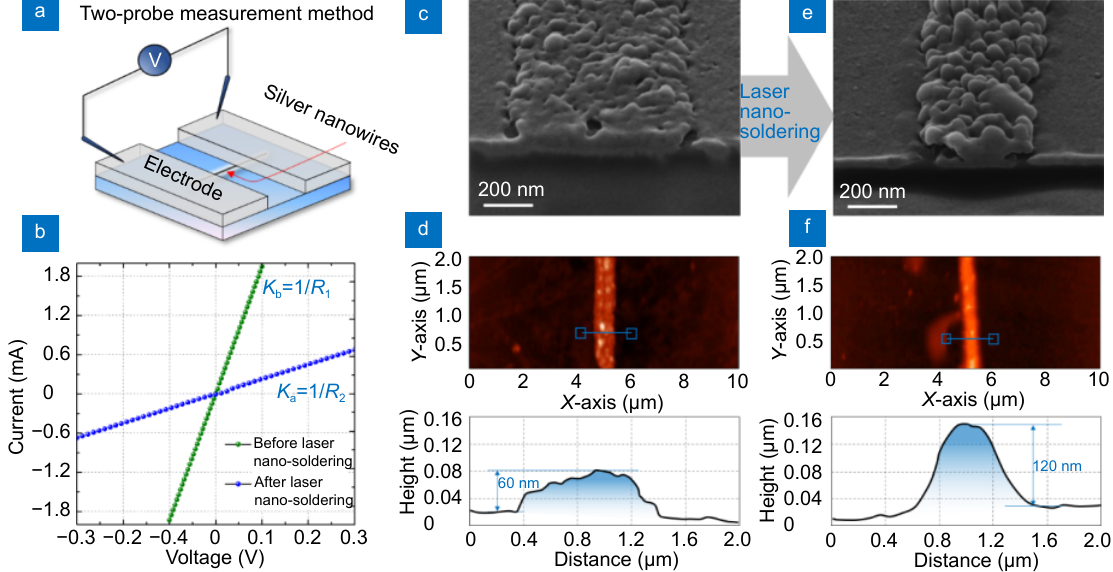
Fig. 3 | ( a ) Schematic of two-probe measurement method. ( b ) I-V curve of the fabricated Ag NWs before and after the laser nanosoldering. ( c , f ) Morphology of Ag NWs cut by focus ion beam. ( d , g ) AFM images and the height profile of the Ag NWs before and after the laser